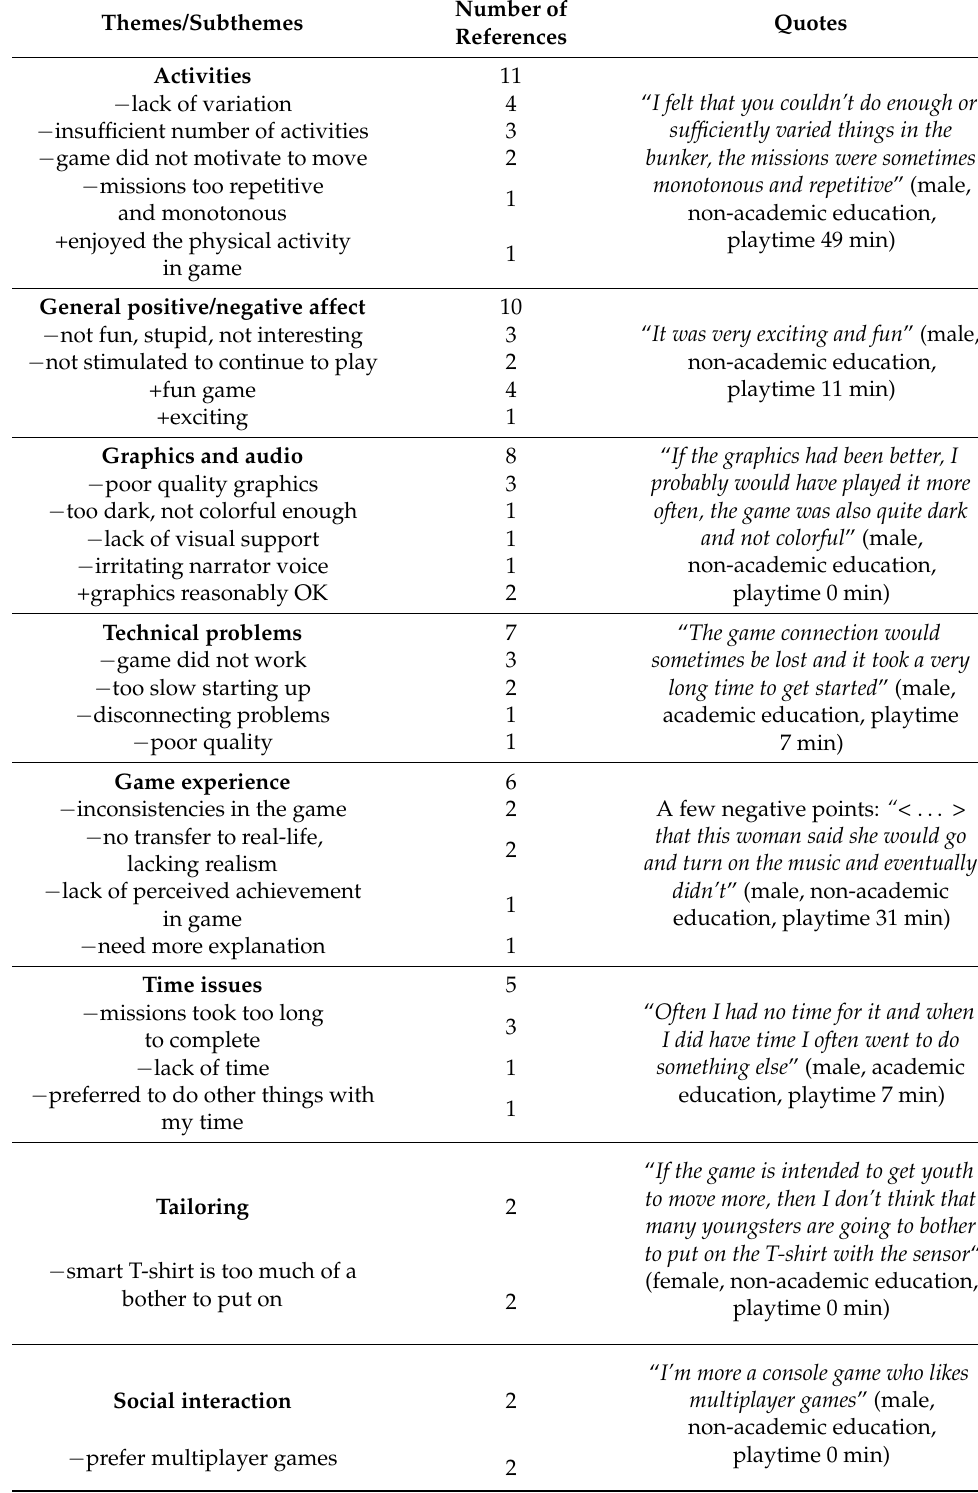
Table 4. Comments provided by participants in the dynamically tailored